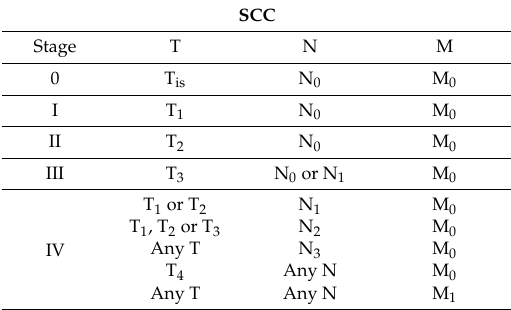
Table 4. American Joint Committee on Cancer Tumor Staging, 8th Edition